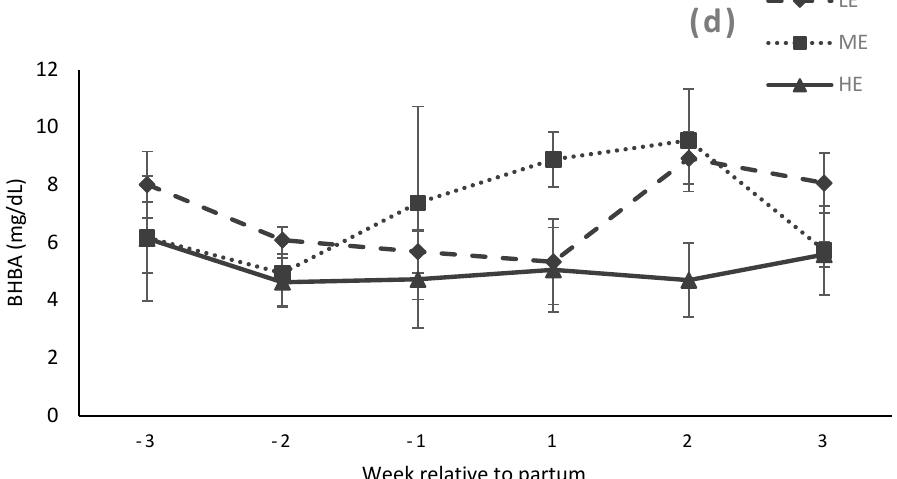
Figure 6. Serum metabolites glucose ( a ), blood urea nitrogen ( b ), triglycerides ( c ), and beta hydrox- ybutyrate ( d ) (mg/dL) of Nili Ravi buffaloes fed a low energy (LE), medium energy (ME) or high energy (HE) level during 9 weeks prepartum. Low, medium, and high energy levels were NE L : 1.30, 1.42, and 1.53 Mcal/kg, respectively, on DM basis in dietary treatments. Values represent LS means ± SEM.